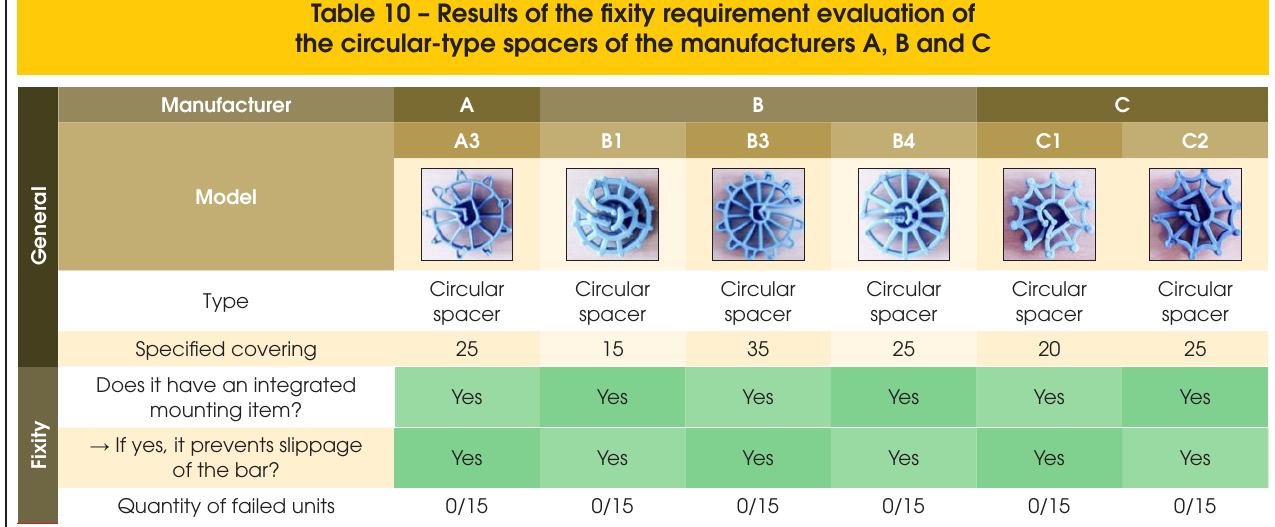
Table 10 – Results of the fixity requirement evaluation